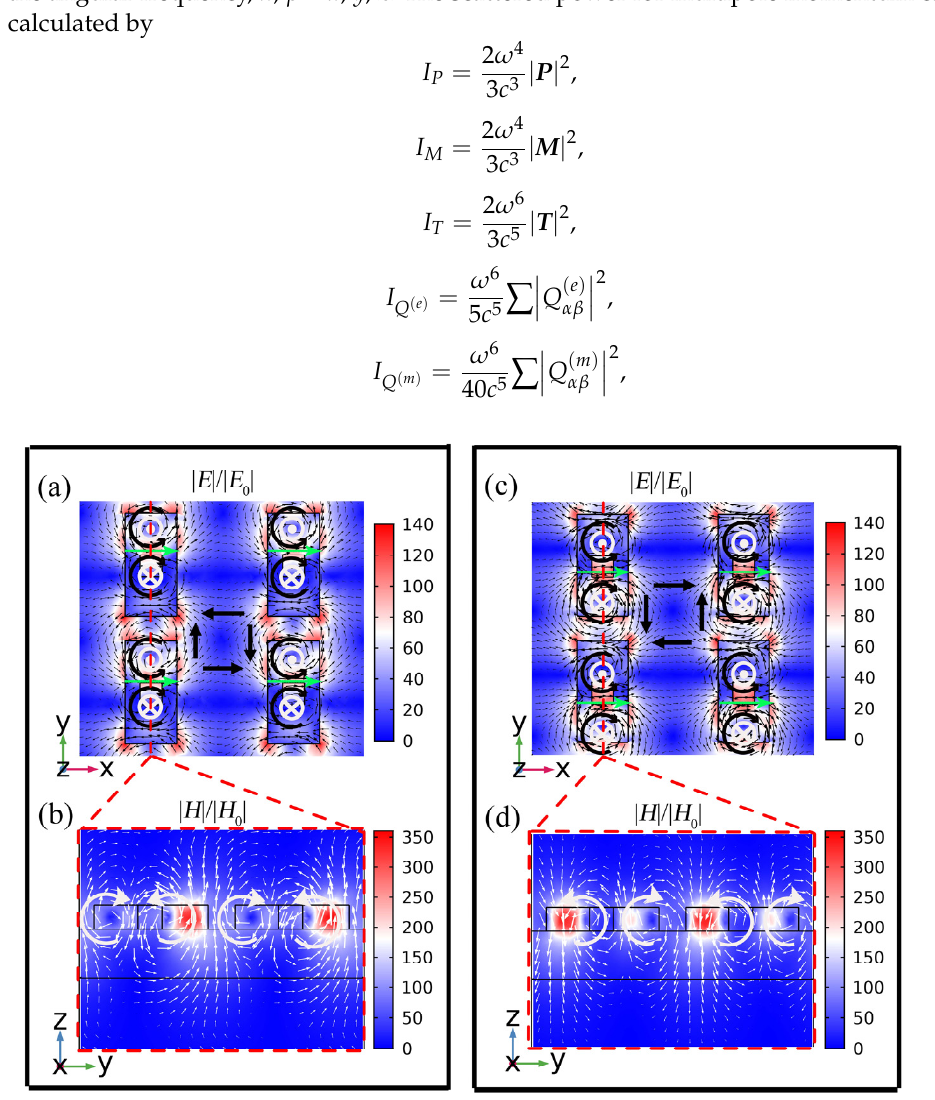
Figure 4. Field distribution at resonant wavelength at Δ = 10 nm ( a , c ) the normalized electric field distribution of the resonant wavelength of mode 1 and mode 2, respectively, in the xoy plane; ( b , d ) the normalized magnetic field distribution of the resonant wavelength of mode 1 and mode 2, respectively, in the yoz plane. The black arrows represent the displacement current direction, and the white arrows represent the magnetic field direction, and the green arrows represent the toroidal dipoles direction.